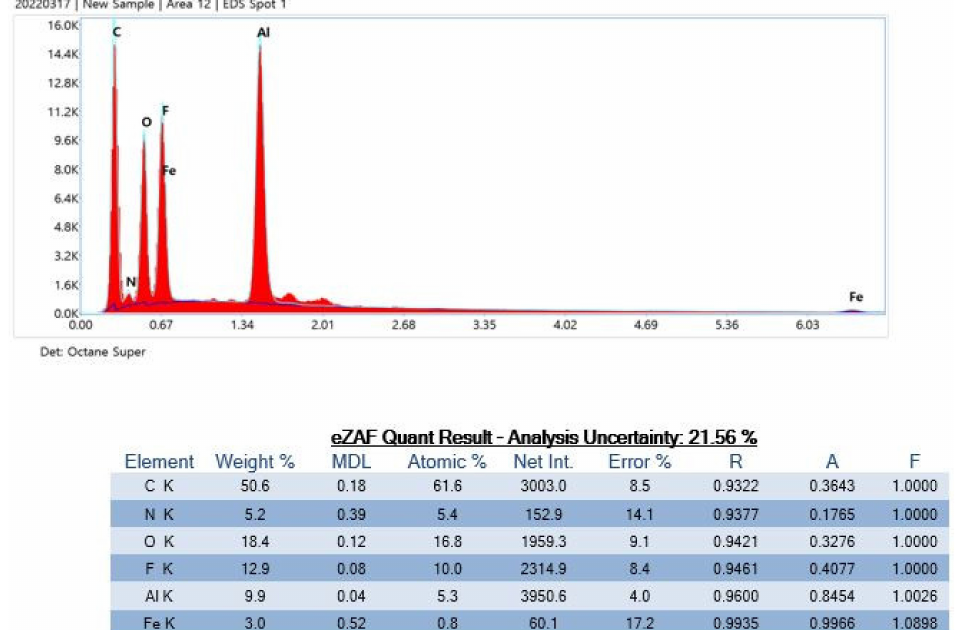
Figure 10. Particle analysis using energy-dispersive X-ray spectrometry. Product J particles contained Al and Fe isotopes. Product D contained Si, Mg, and Ca isotopes (Figure 11).